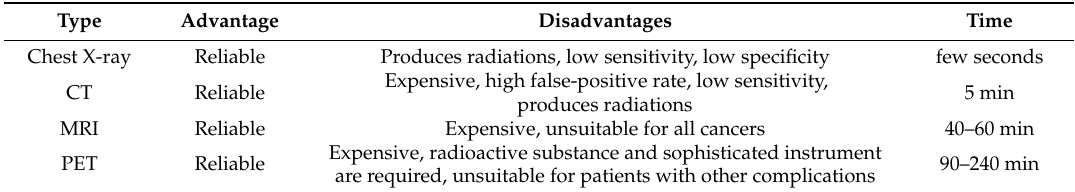
Table 1. Conventional lung screening methods